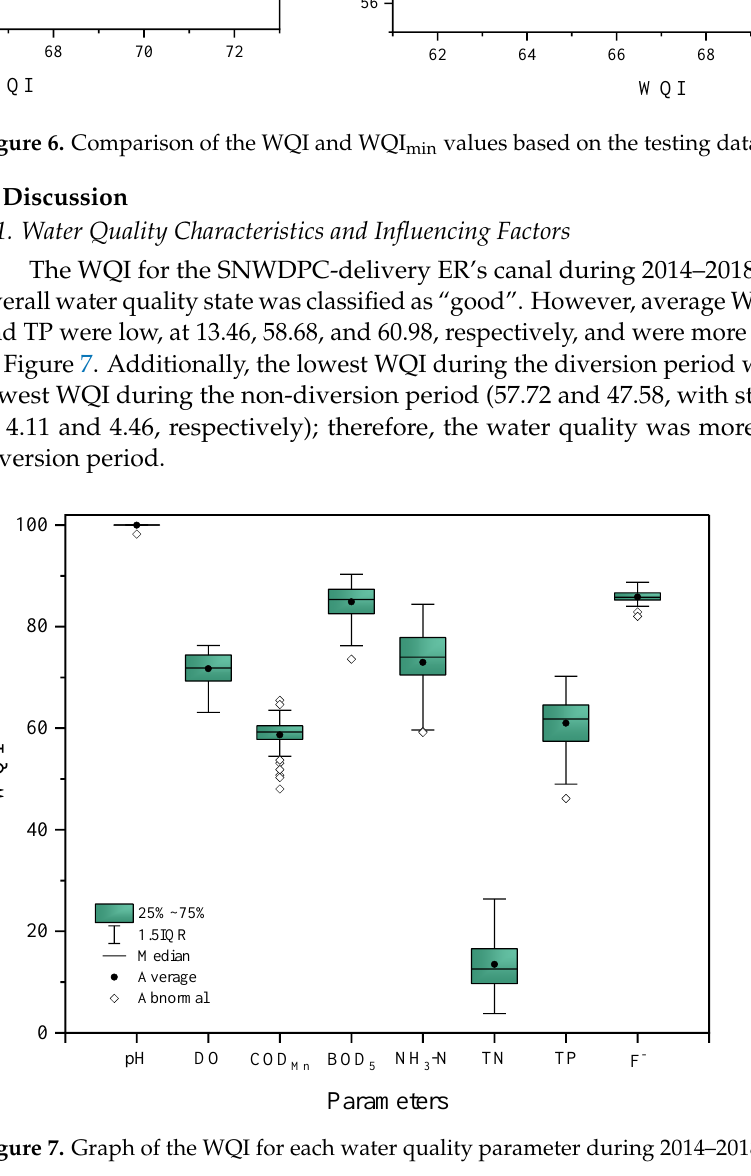
Figure 7. Graph of the WQI for each water quality parameter during 2014 – 2018.